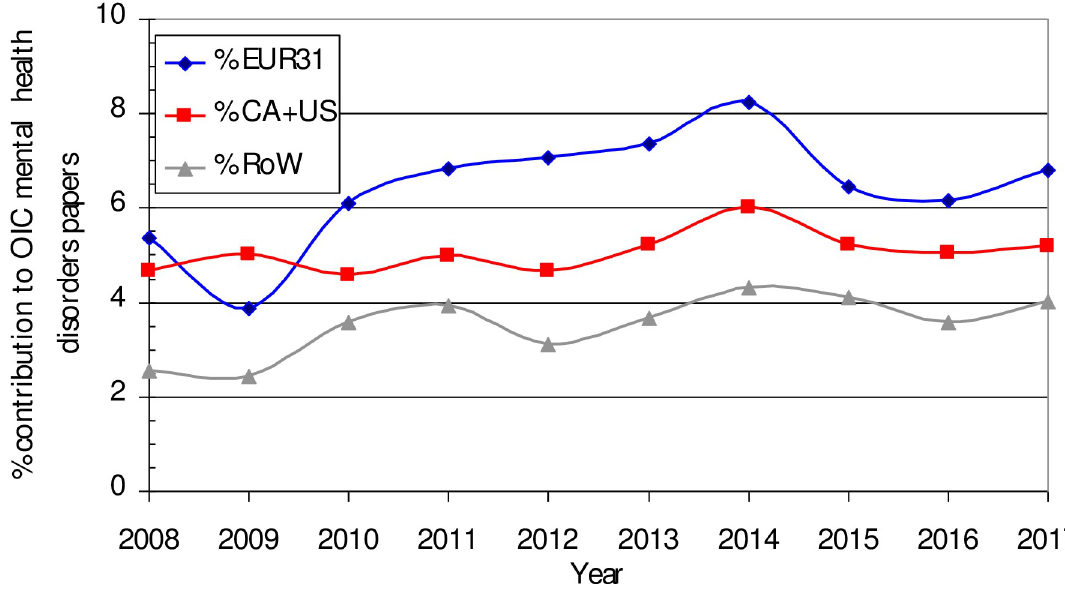
Fig 2. The contributions of non-OIC countries to WoS OIC mental disorders research papers, 2008–17.